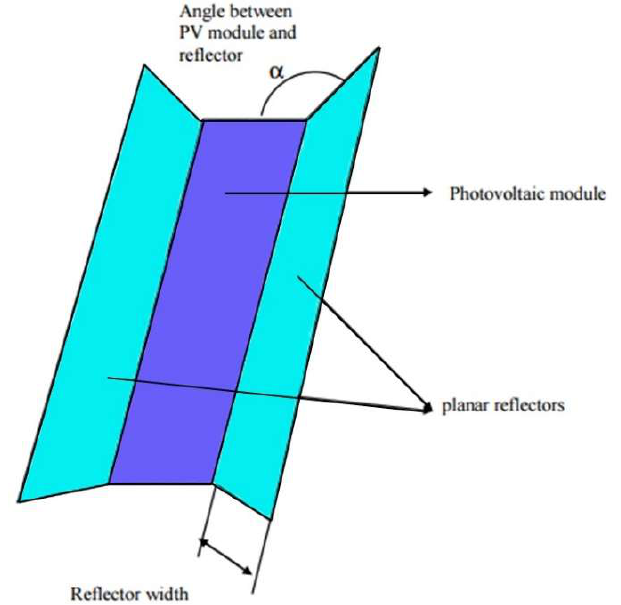
Figure 5. An overview of Al- foil based Bi reflector system (Al-BRS). Electrical Modeling